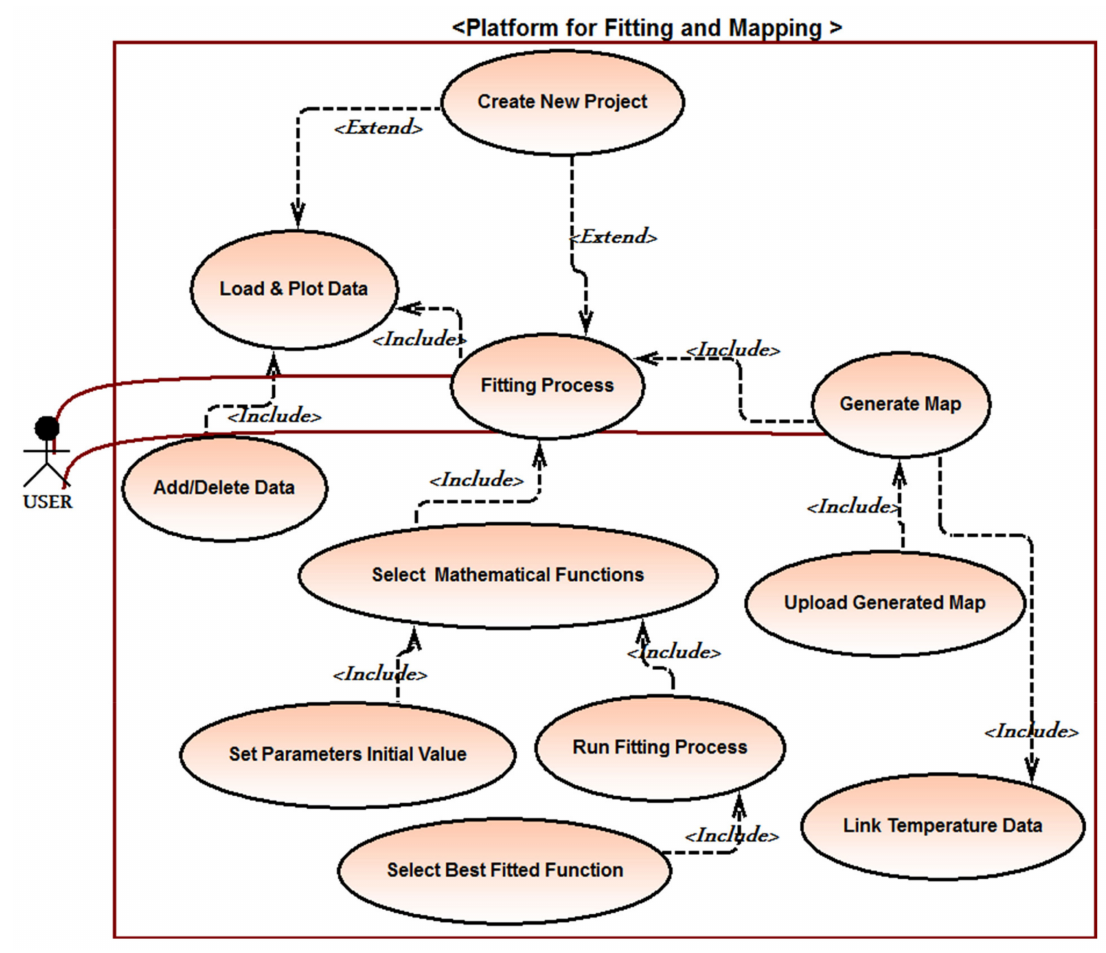
Figure 1. Use case diagram presenting the interactions among the platform components and their functionalities. Each circle represents a feature implemented within the decision support system (DSS). The links from the user to a feature represent the direct interactions of the user with the DSS, while the arrows with labels “include” characterize the relationships and level of dependency between